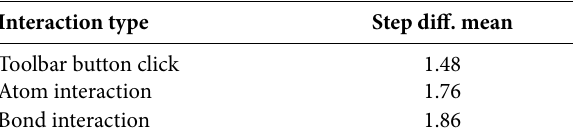
Table 4: Step difficulty mean by interaction type Interaction type